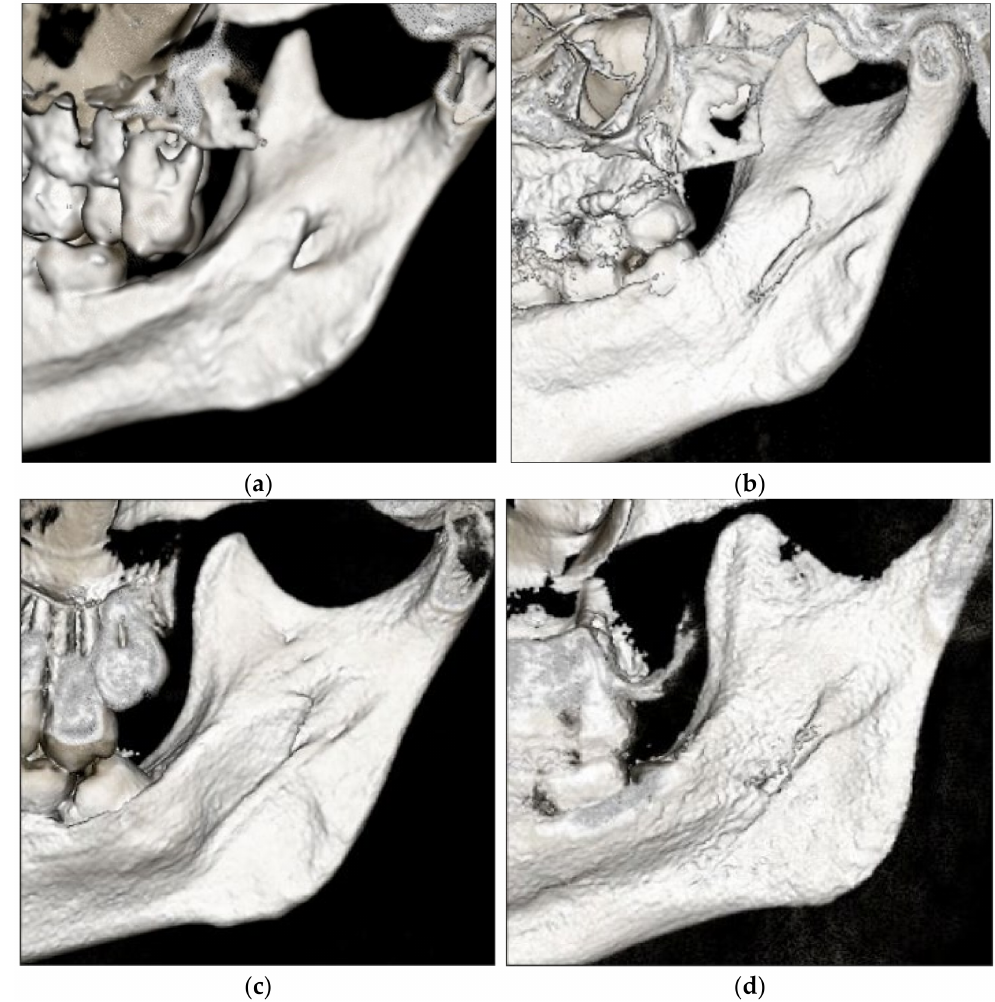
Figure 2. Different shapes of the lingula: ( a ) nodular, ( b ) truncated, ( c ) triangular and ( d ) assimilated. The overall mean height of the lingula (in mm) in both of the genders was 7.73 ± 0.44, and it was 7.83 ± 0.47 on the right side and 7.63 ± 0.41 on the left side. Statistically significant differences between the genders are shown in Table 3. Within the gender variable, significant differences in the height of the lingula between the right and left sides were observed in both males ( p = 0.000; z = − 9.471) and females ( p = 0.000; z = −